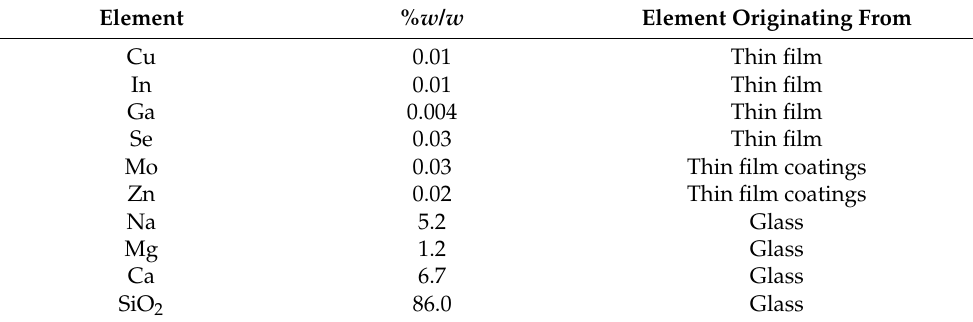
Table 1. Composition of the thin film-coated glass fragments.